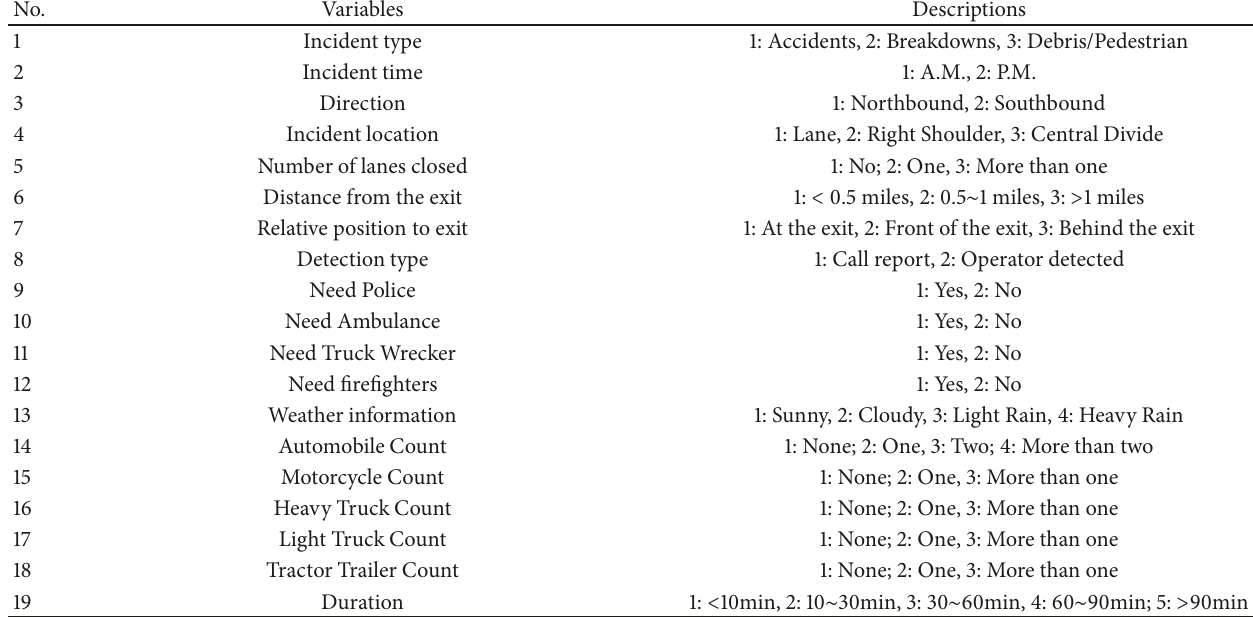
Table 2: The relevant variables of traffic incident duration selected in this